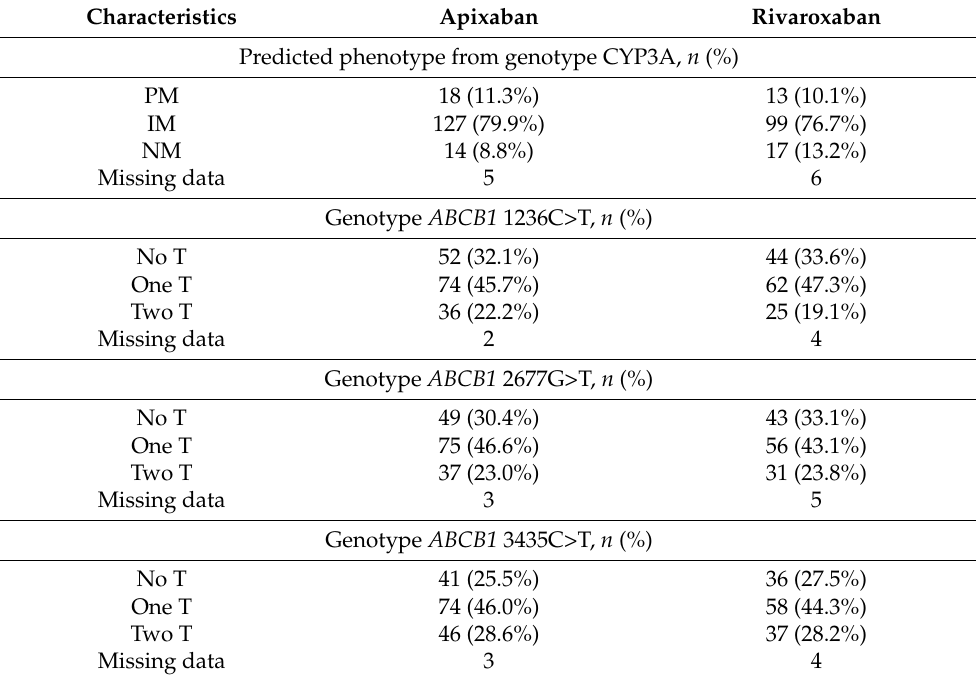
Table 2. Genotype analysis